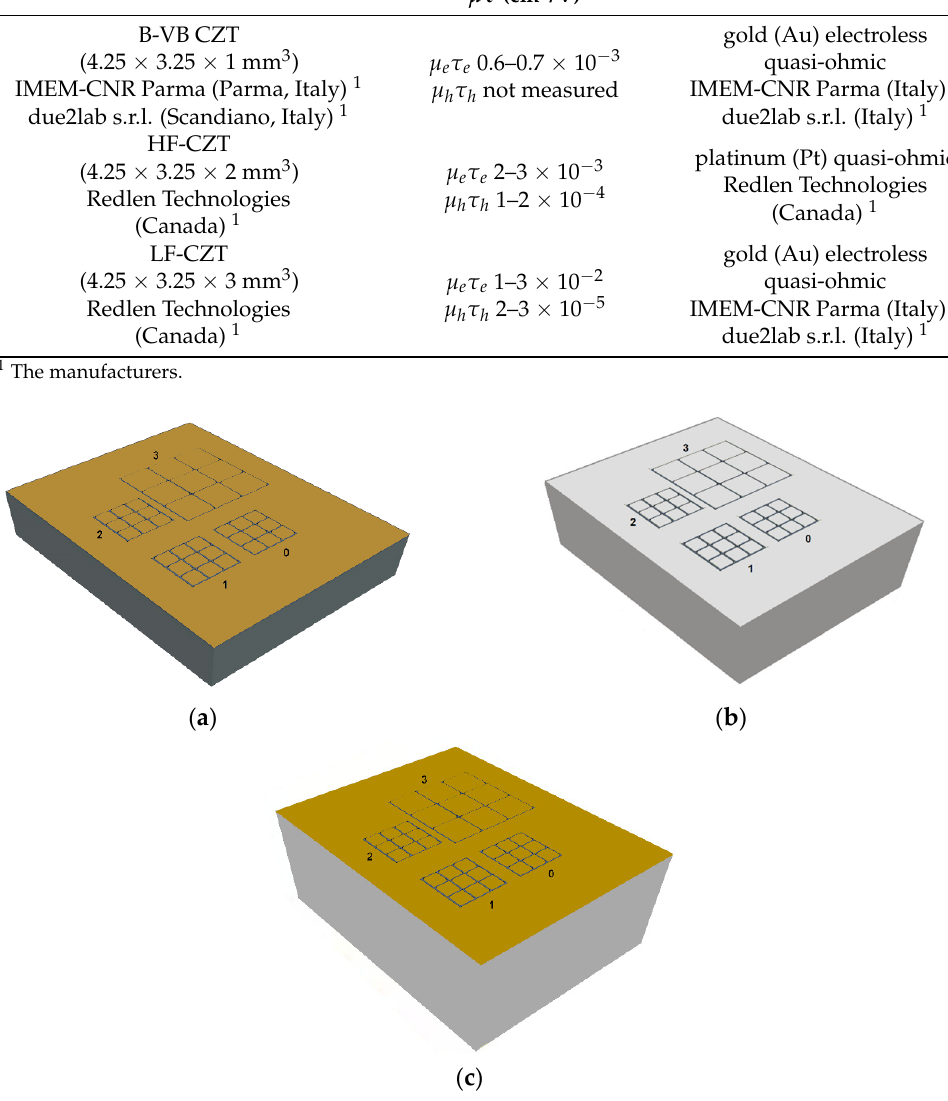
Figure 1. The anode layout of the three CZT pixel detectors. ( a ) The 1-mm thick B-VB CZT pixel detector, ( b ) the 2-mm thick HF-CZT pixel detector, and ( c ) the 3-mm LF-CZT pixel detector. The different colours highlight the related differences in both the CZT crystals and electrical contacts.